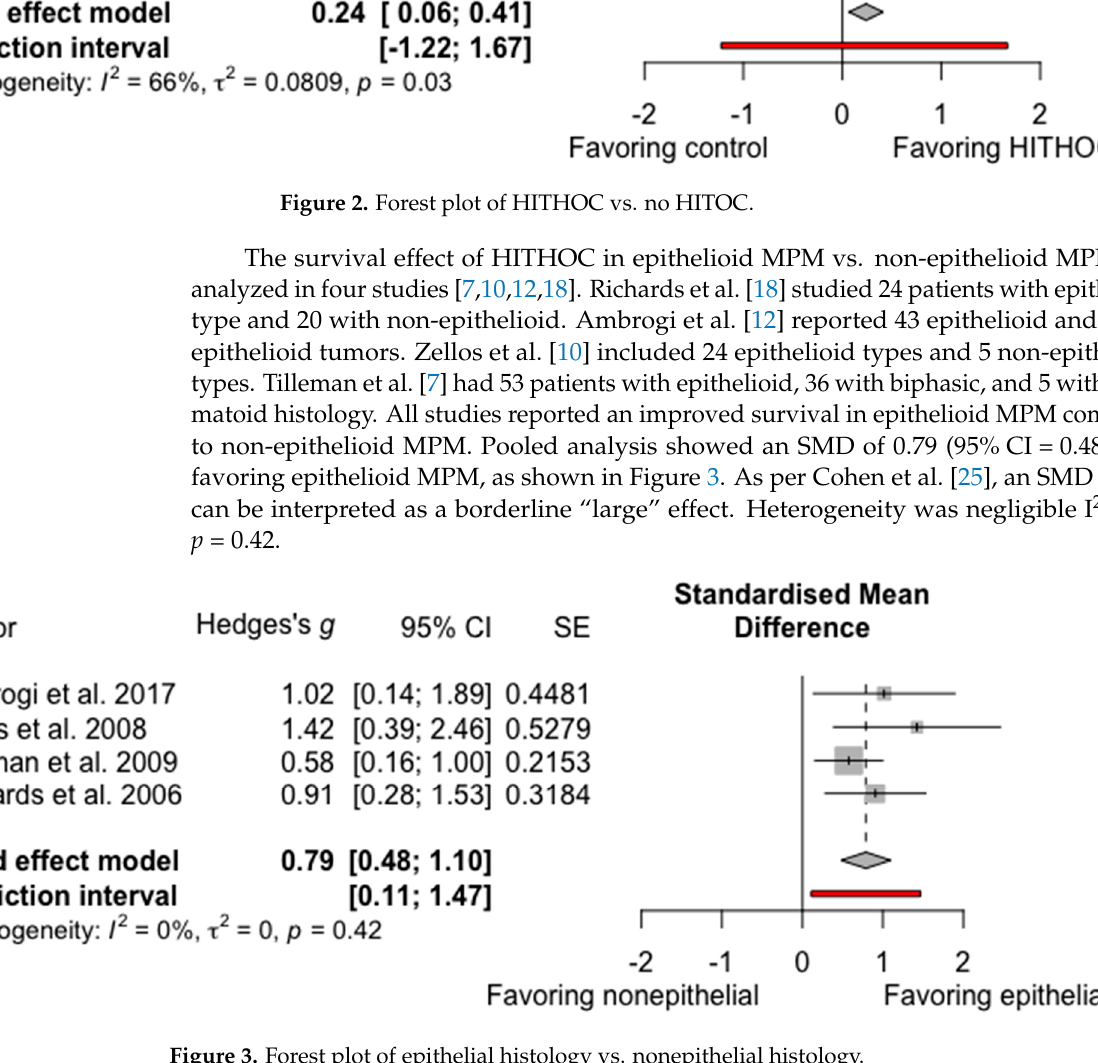
Figure 3. Forest plot of epithelial histology vs. nonepithelial histology Complications Related to HITHOC